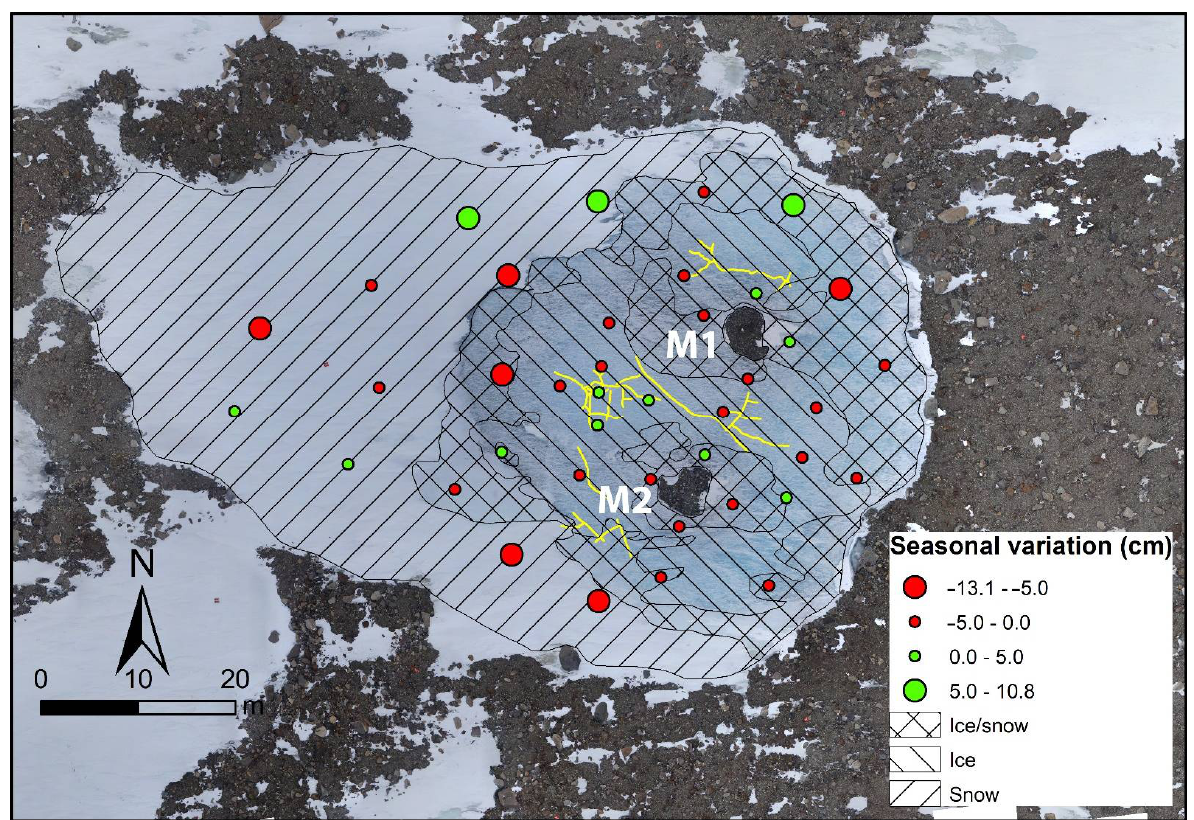
Figure 5. Seasonal snow and ice dynamic at the study site. The orthophoto has been obtained with the survey on 3/12/2018 while the surface type classes remain constant during all the summer 2018–2019. In addition, punctual cumulative height variations recorded at each tube from 11/11/2018 to 16/01/2019 are reported. Colors refer to sublimation (red) and accretion/accumulation (green), while dots diameter refers to high values (big) or low values (small). Yellow lines indicate the major dilation cracks on the ice surface.